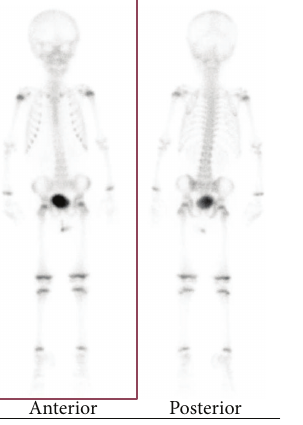
Figure 3: Whole body bone scan showing no bone